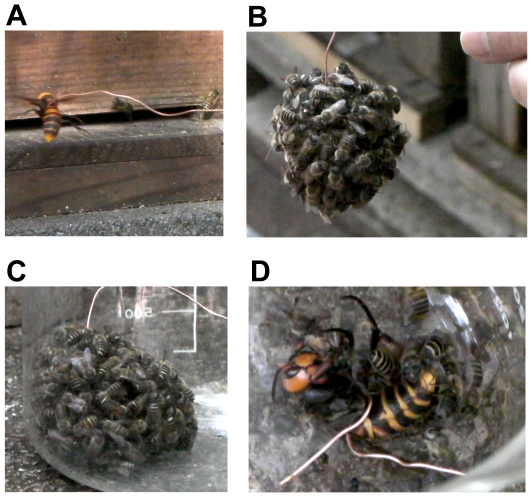
Sampling of workers from an artificially formed hot defensive bee ball.(A) Presentation of a wire-hung hornet to the beehive as a decoy. (B) Hundreds of workers form a hot defensive bee ball surrounding the wire-hung giant hornet. (C) Bee ball recovered in a glass beaker. (D) The giant hornet is dead 60 min after the bee ball forms.